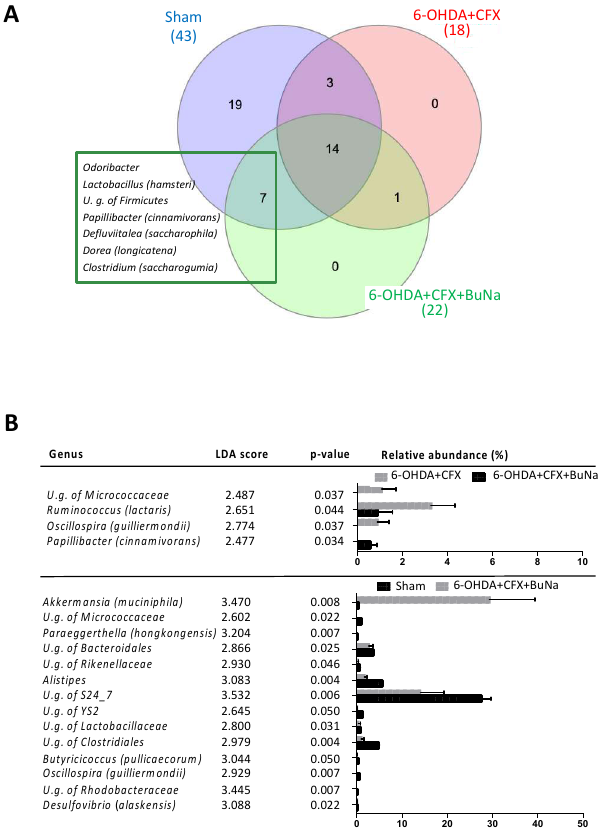
Figure 7. BuNa-restructured gut microbiota in 6-OHDA+CFX mice. ( A ) Venn diagram illustrating bacterial genera overlaps among core microbiomes with an attached list of the 7 genera shared by Sham and 6-OHDA+CFX+BuNa mice and missing in 6-OHDA+CFX mice. ( B ) Gut microbiota differences at genus taxonomic level based on linear discriminant analysis (LDA) combined with effect size (LEfSe) algorithm ( p > 0.05 for both Kruskal–Wallis and pairwise Wilcoxon tests and a cutoff value of LDA score above 2.0). LDA scores, p -values, and relative abundance of key genera discriminating bacterial communities are reported in each panel.